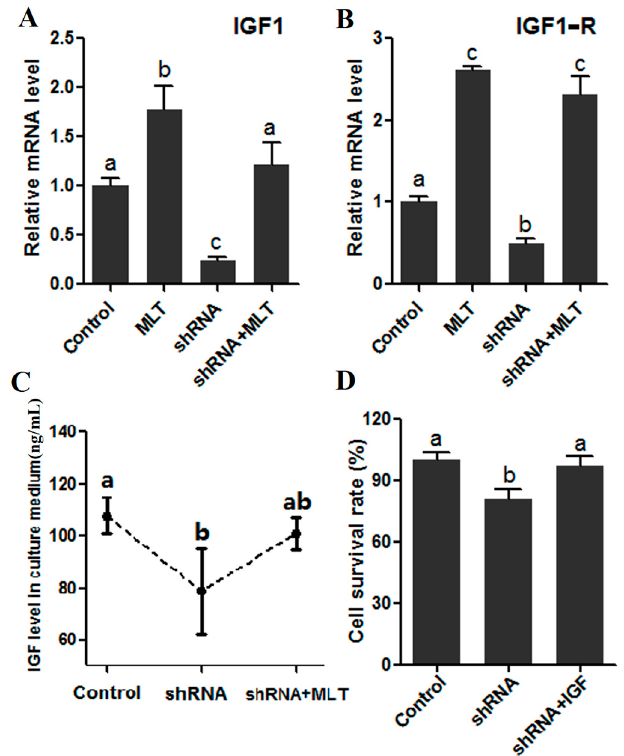
Figure 6. Effect of MT1 knock-down on IGF/IGF1-R signaling. ( A ) The expression of IGF1; ( B ) the expression of IGF1-R; ( C ) IGF level in culture medium; ( D ) the effect on the cell survival rate. Different superscript letters (a–c) represent significant differences of these columns ( p < 0.05).